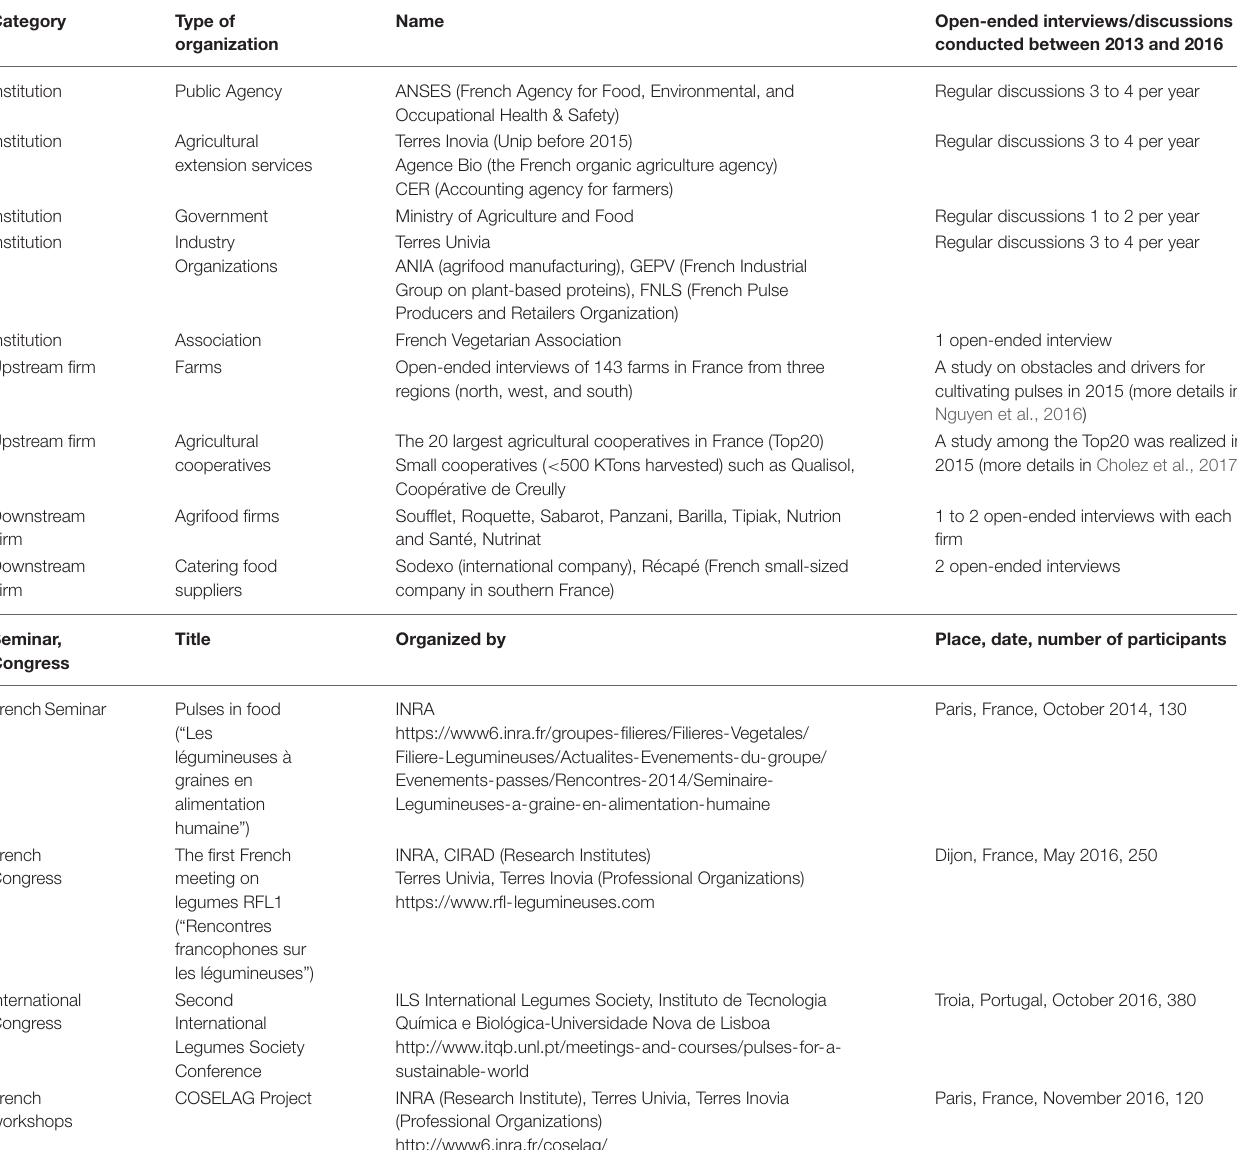
TABLE 1 | Main types of information provided by different